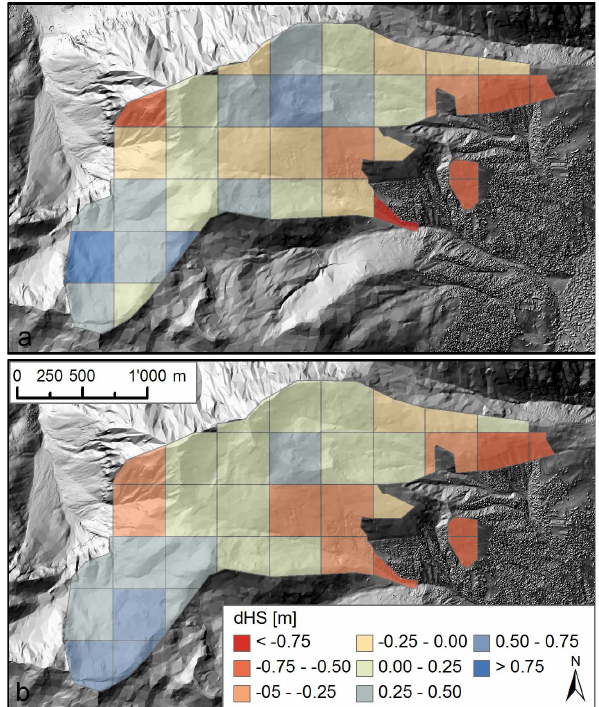
Fig. 6. Comparison of dHS for the Wannengrat in April 2009, ag- gregated to (a) a 400m grid form ALS-measurements, and (b) mod- elled with a regression model with d E , SL and